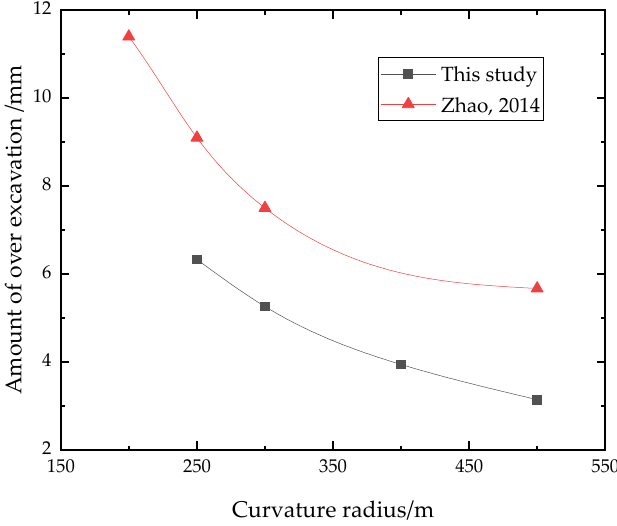
Figure 10. Amount of over excavation versus curvature radius [45]. Curves of horizontal displacement with curvature radiuses of the tunnel are shown in Figure 11. Figure 11a shows that horizontal displacement of surrounding soil at the outer side of the tunnel decreased with the increase in curvature radius. For the four tunnels, maximum displacement values of soil above the tunnel top were 5.58 mm, 5.33 mm, 5.09 mm and 4.88 mm, with a 12.5% decrement. Maximum horizontal displacement values of soil between the tunnel top and bottom were − 3.34 mm, − 3.10 mm, − 2.83 mm and − 2.58 mm, with an absolute value decrement of 22.8%.